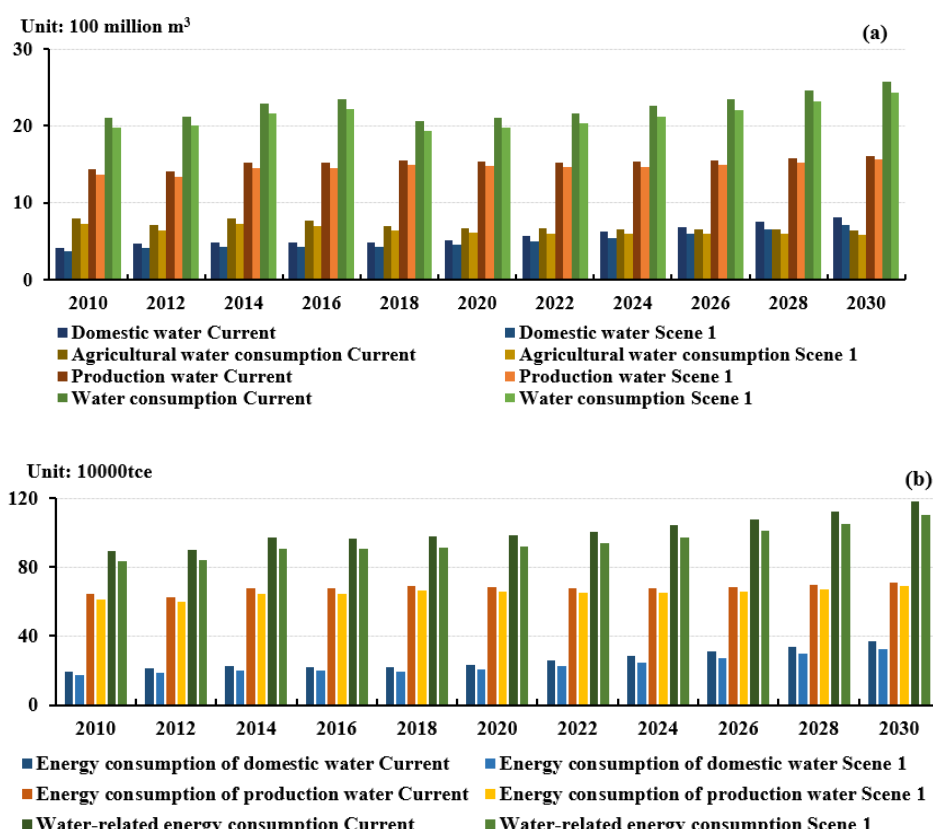
Figure 6. Simulation results of water-related indicators and energy-related indicators under WSS: ( a ) water-related indicators: domestic water consumption, agricultural water consumption, production water consumption, and water consumption; ( b ) energy-related indicators: energy consumption of domestic water, energy consumption of production water, and water-related energy consumption.